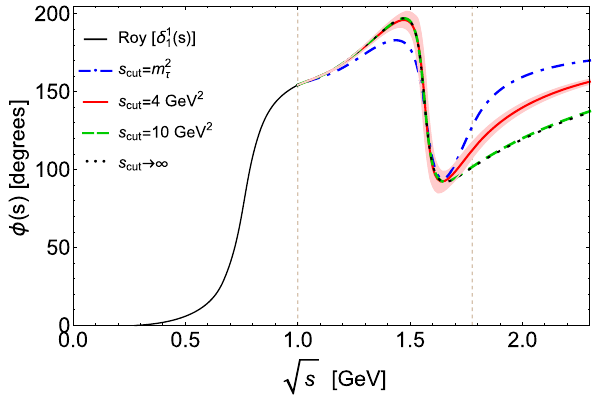
Fig. 2 Form factor phase as extracted from fits to the pion vector form factor Belle data [31] according to the representation presented in Eq.(26) for four representative values of s cut in the dispersive integral. The P -wave ππ phase shift solution of the Roy equations [41] δ 1 used up to 1 GeV (solid black curve) and the variations due to s cut are given by the dot-dashed blue ( s cut = m 2 τ ), solid red ( s cut = 4 GeV 2 ) , dashed green ( s cut = 10 GeV 2 ) and dotted black ( s cut → ∞ ) curves, respectively. The two vertical dashed brown lines are placed at 1 GeV √ s = m τ , and denote, respectively, the range where the phase shift and from ππ scattering is used and the validity of the parametrization of the form factor phase shift. All phases are smoothly guided to π for s > m τ . See main text for details